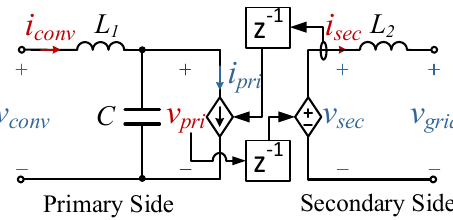
Figure 12. Equivalent circuit of the partitioned LCL filter used in the Real-time